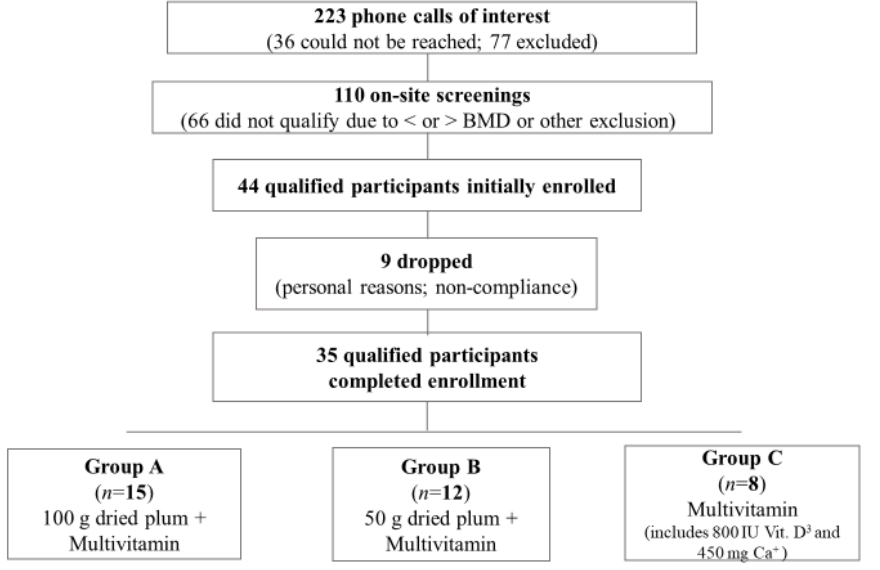
Figure 1. Study Flowchart. Abbreviations: Bone Mineral Density, BMD. Table 1. Baseline characteristics between and among groups.